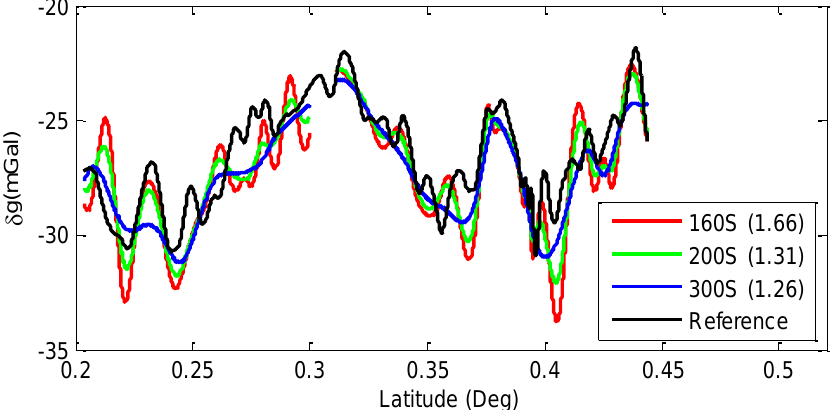
Figure 15. Reference compared with average disturbances using different filter